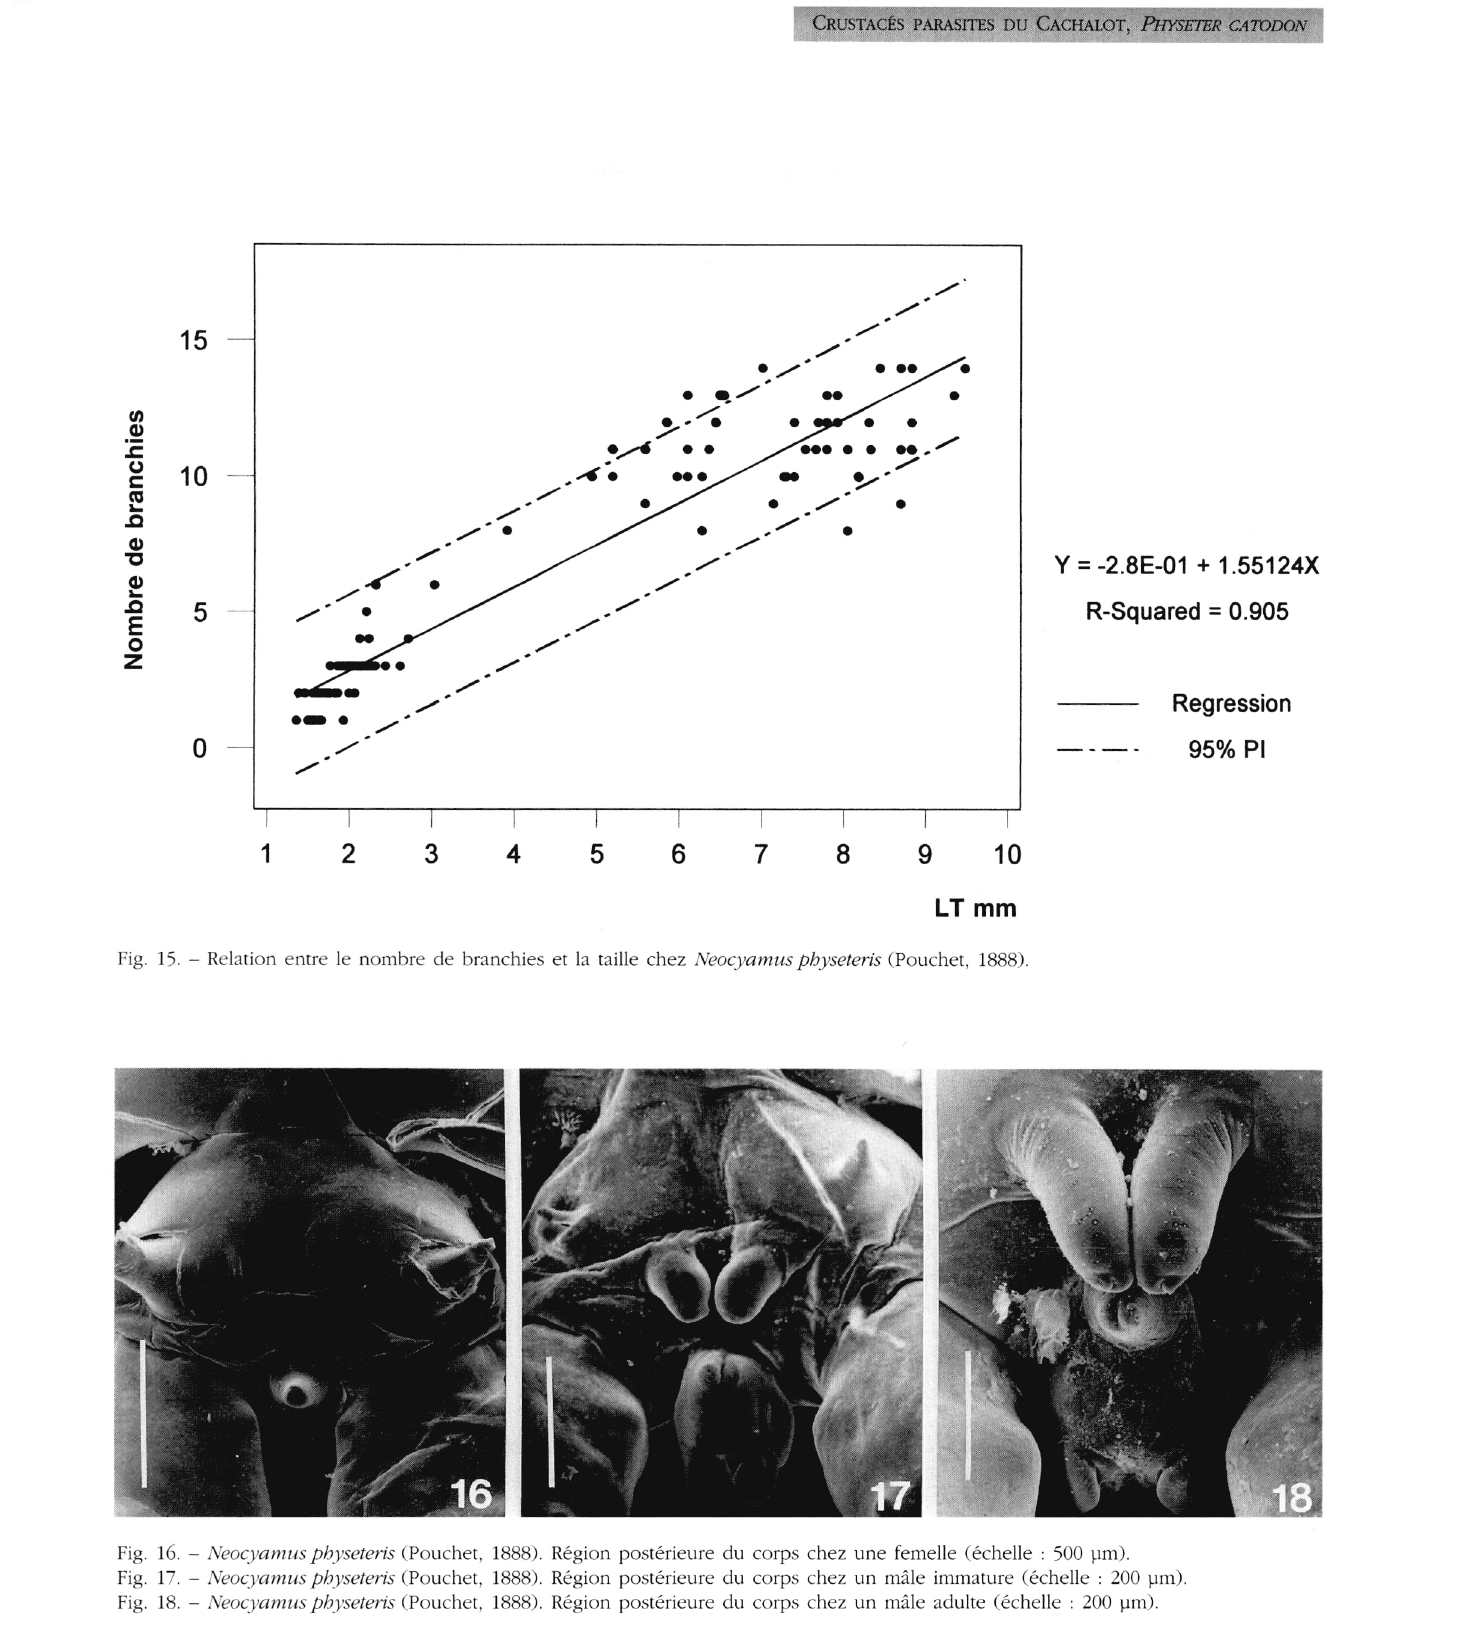
Fig. 16. - Neocyamus physeteris (Pouchet, 1888). Région postérieure du corps chez une femelle (échelle : 500 μ m). Fig. 17. - Neocyamus physeteris (Pouchet, 1888). Région postérieure du corps chez un mâle immature (échelle : 200 μm). Fig. 18. - Neocyamus physeteris (Pouchet, 1888). Région postérieure du corps chez un mâle adulte (échelle : 200